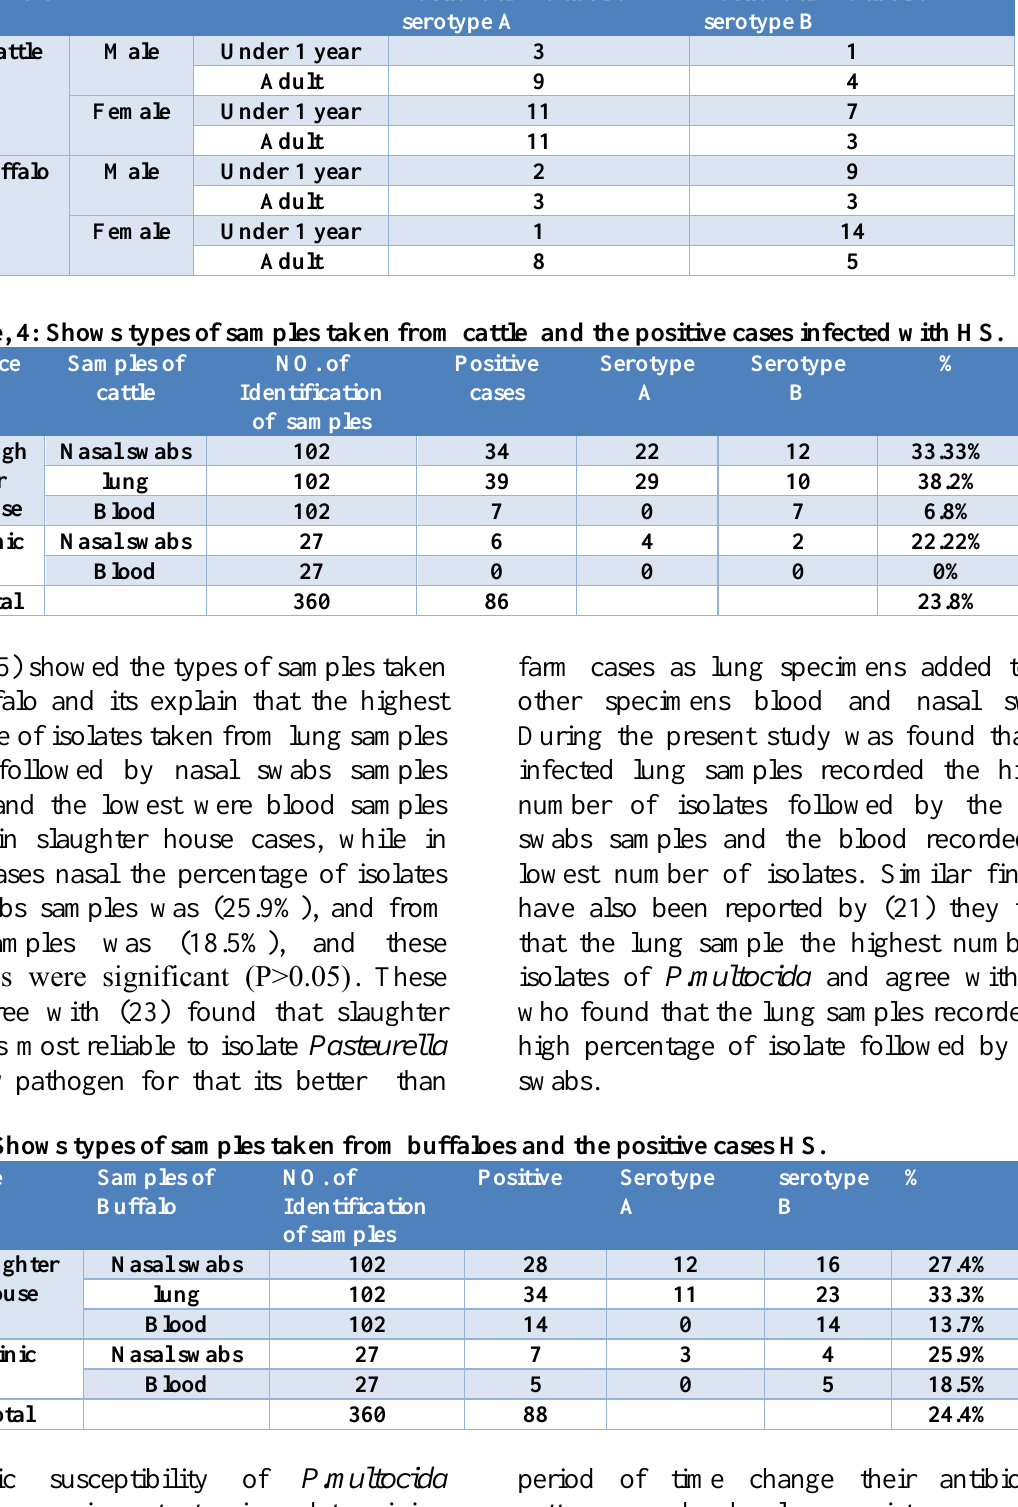
Table, 3: Shows types of pasteurella detected by PCR assay Animals